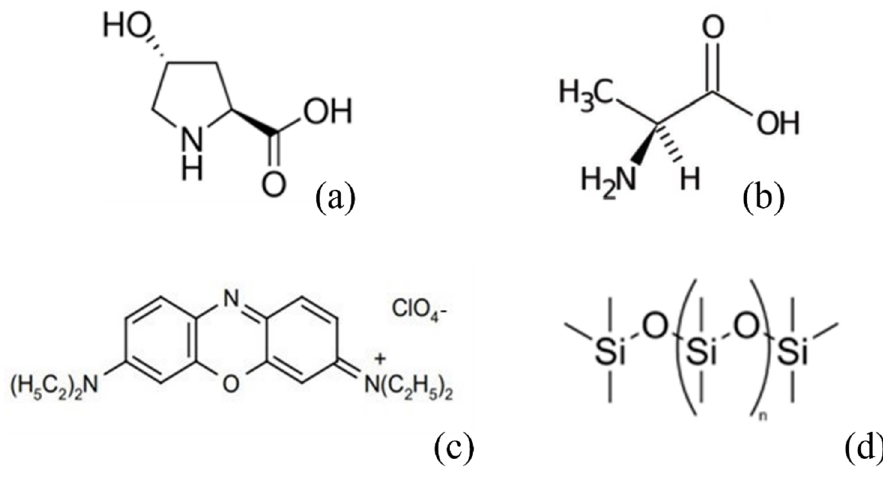
Figure 2. Molecular structure of: ( a ) Trans-4-Hydroxy-L-proline; ( b ) L-alanine; ( c ) oxazine 725; and ( d ) Polydimethylsiloxane.